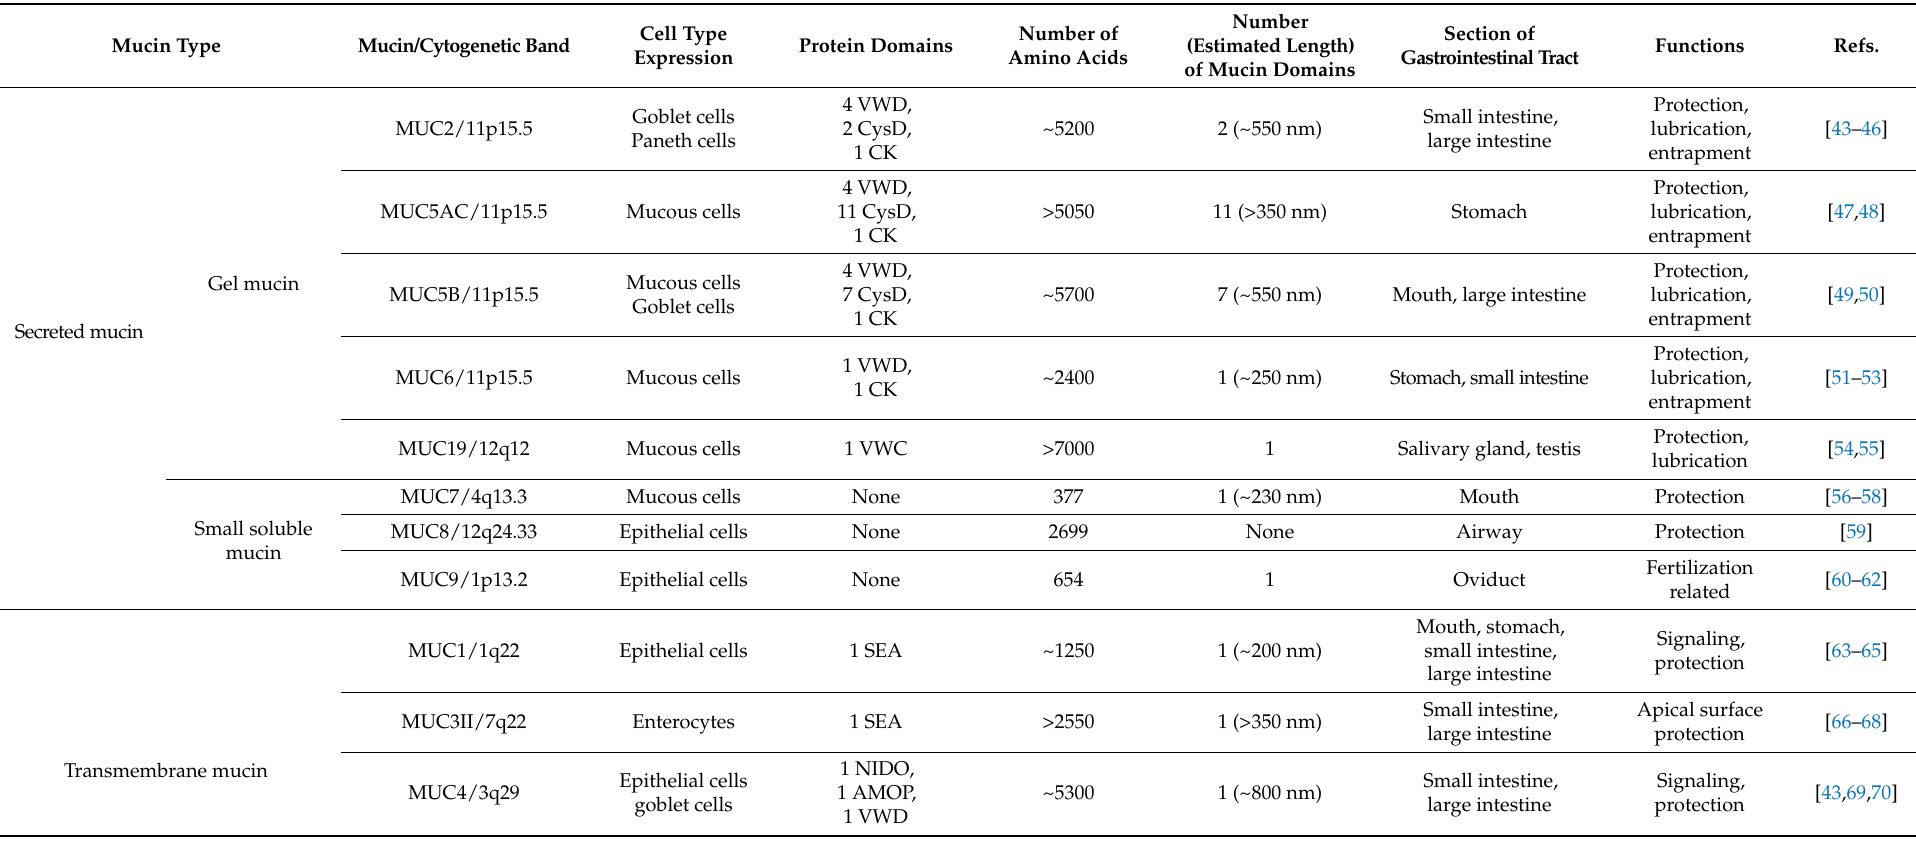
Table 1. Summary of classification and biological characteristics of